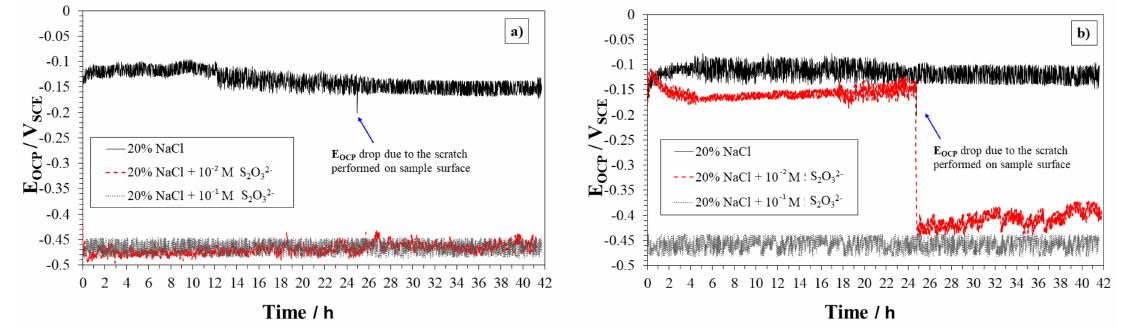
Figure 7. E OCP -strain trends of DSS 2304 ( a ) and LDSS 2404 ( b ) during immersion in 20% NaCl solution at 80 ◦ C, in the absence and presence of 10 − 2 and 10 − 1 M S 2 O 3 2 −